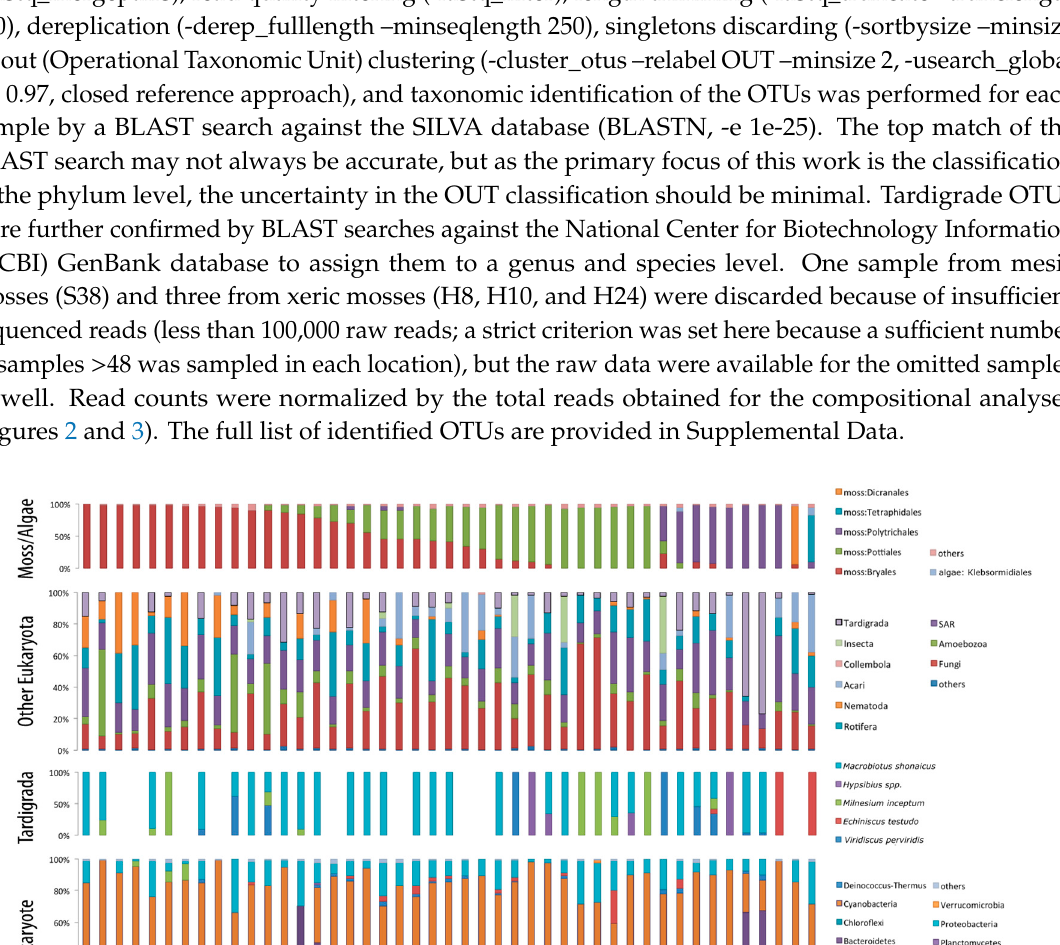
Figure 3. Amplicon abundance ratios in mesic mosses. Relative abundances of amplicon reads within OTUs assigned to moss/lichen, other Eukaryota, tardigrades, and bacteria are shown separately. Forty samples were collected from mosses or lichens on rocks or tree surfaces within a cedar forest, and eight samples were collected from semi-xeric mosses near the road just outside of the forest. Moss species varied among samples, but lichen samples were dominated by the green algal genus